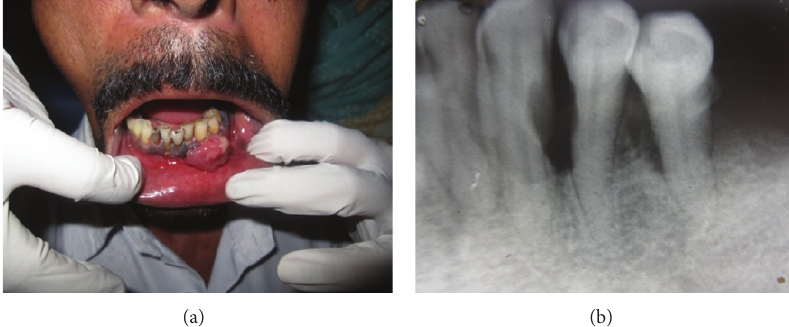
Figure 1: (a) Intraoral view of lesion in anterior mandibular region. (b) IOPA showing mild rarefaction and bone loss in the 33–35 region.